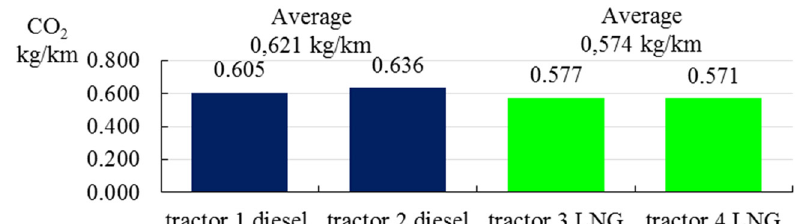
Figure 3: CO 2 production per 1 km for tractors with semi - trailers.